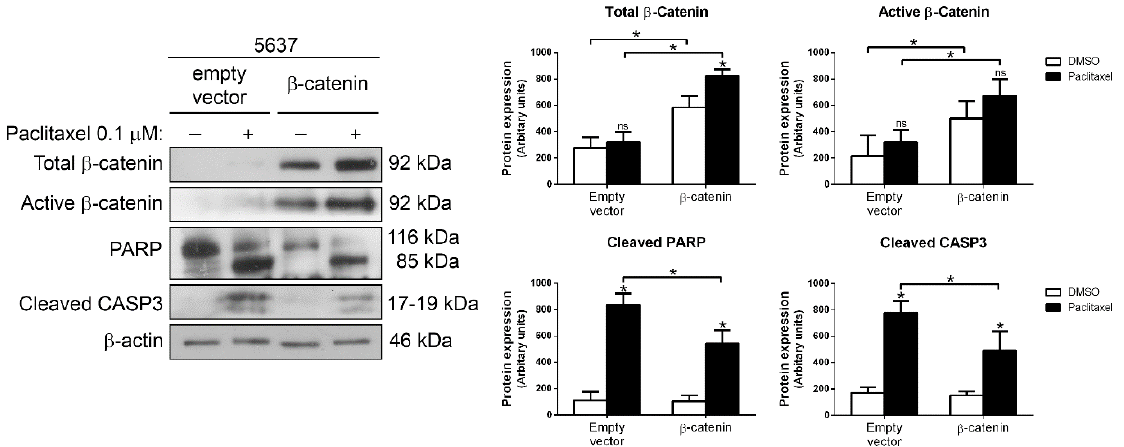
Figure 2. Overexpression of β -catenin reduces paclitaxel sensitivity in 5637 cells. Western blots of PARP, cleaved caspase-3, total β -catenin, and active β -catenin in 5637 cells transiently transfected with pCMV6-XL5-CTNNB1 or with empty vector and treated with DMSO (vehicle) or 0.1 µM paclitaxel for 48 h. β -actin was used as a loading control. Histograms show the densitometric analysis of the indicated proteins. Data are presented as mean ± SD. * p value < 0.05 from Student’s t test (n ≥ 3). ns, not significant.